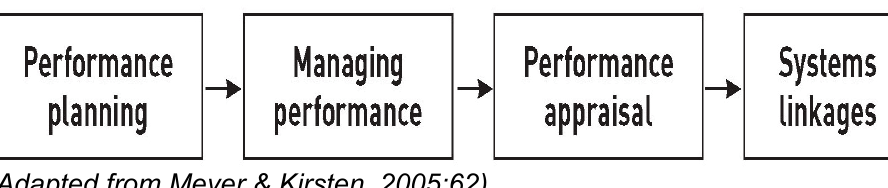
Figure 1: Proposed model of performance management system in Municipalities